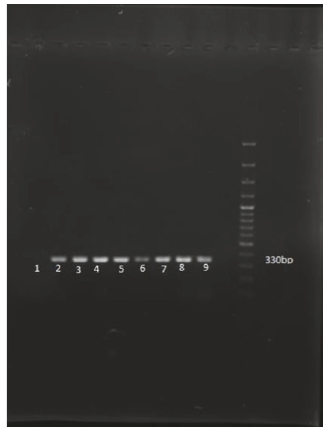
Figure 1: PCR amplification of 16s rRNA gene (330 base-pair) of Y. enterocolitica. Lane1:negativecontrol;Lanes2to8:positivesamples; Lane 9: positive control; Lane 12: 100 base pairs plus DNA